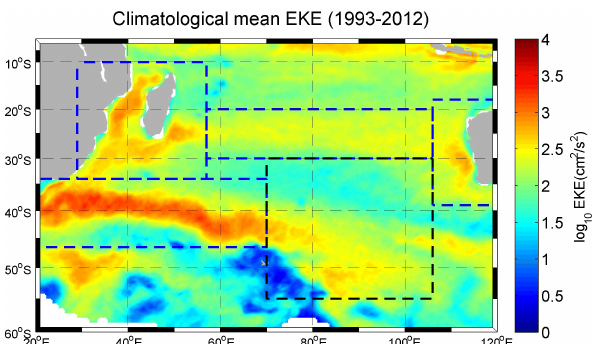
Figure 10. Climatological mean of eddy kinetic energy in the SIO derived from altimetry data over 1993–2012. Blue rectangles represent the Leeuwin Current region (106–120 ◦ E, 18–39 ◦ S), a band along 25 ◦ S (57–106 ◦ E, 20–30 ◦ S), Mozambique Channel (29–57 ◦ E, 10–34 ◦ S) and Agulhas Current (20–70 ◦ E, 34–46.5 ◦ S). Black rectangle represents the interior ocean (70–106 ◦ E, 30–55 ◦ S) in the